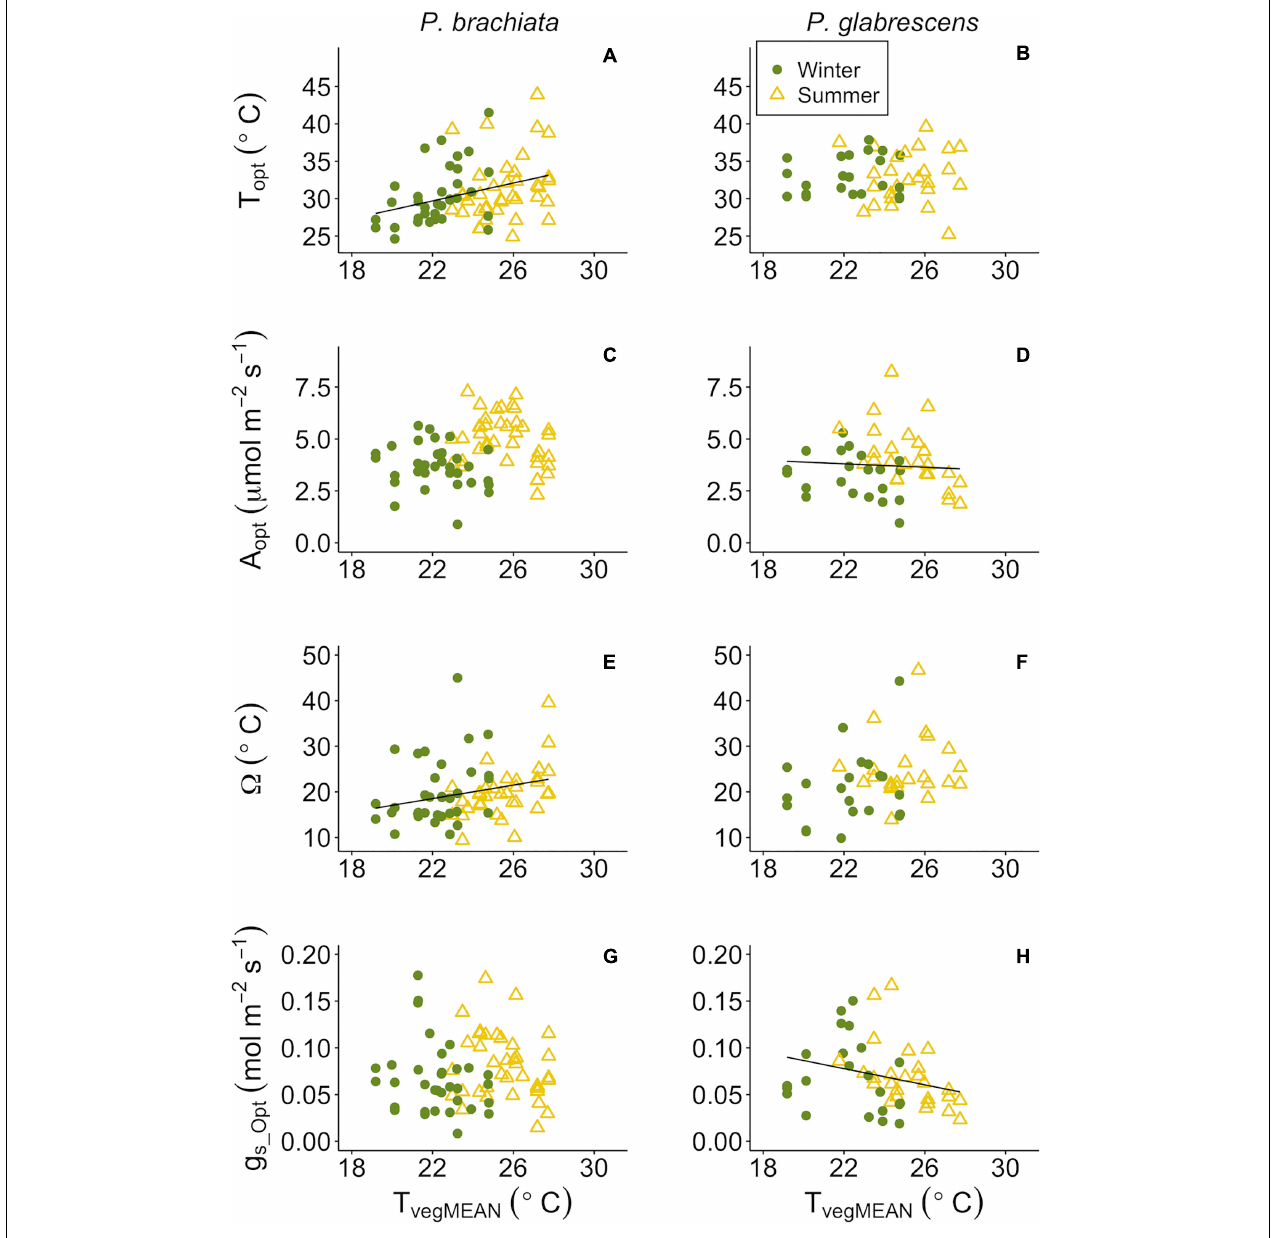
FIGURE 6 | Photosynthetic parameter responses to mean daily vegetation temperature ( T vegMEAN ). (A) Psychotria brachiata optimum temperature of photosynthesis ( T opt ) response to T vegMEAN of winter (green circles) and summer (yellow triangles), (B) Piper glabrescens T opt response to T vegMEAN , (C) P. brachiata rate of photosynthesis at T opt ( A opt ) response to T vegMEAN , (D) P. glabrescens A opt response to T vegMEAN , (E) P. brachiata photosynthetic thermal niche ( (cid:127) ) response to T vegMEAN , (F) P. glabrescens (cid:127) response to T vegMEAN , (G) P. brachiata rate of stomatal conductance at T opt ( g s_Opt ) response to T vegMEAN , and (H) P. glabrescens rate of stomatal conductance at T opt ( g s_Opt ) response to T vegMEAN . Fit lines (green - winter; yellow – summer) indicate a significant interaction between T vegMEAN and season ( Supplementary Table S7 ). A solid black line is fit when there is a significant T vegMEAN response but no interaction ( Supplementary Table S7